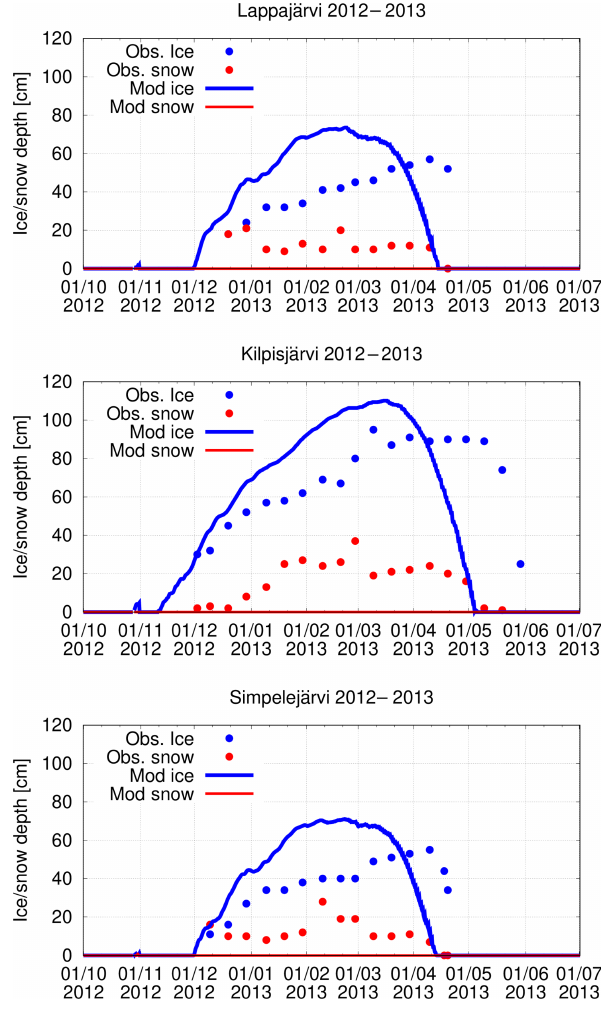
Figure 10. Evolution of ice (blue) and snow (red) thicknesses at lakes Lappajärvi, Kilpisjärvi and Simpelejärvi during winter 2012–